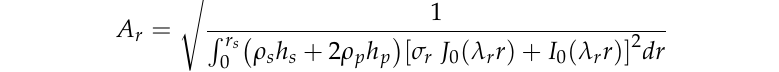
Table 1. The eigenvalues of the first three resonance frequencies for clamped-edge disk. r 1 2 3 λ 1 r